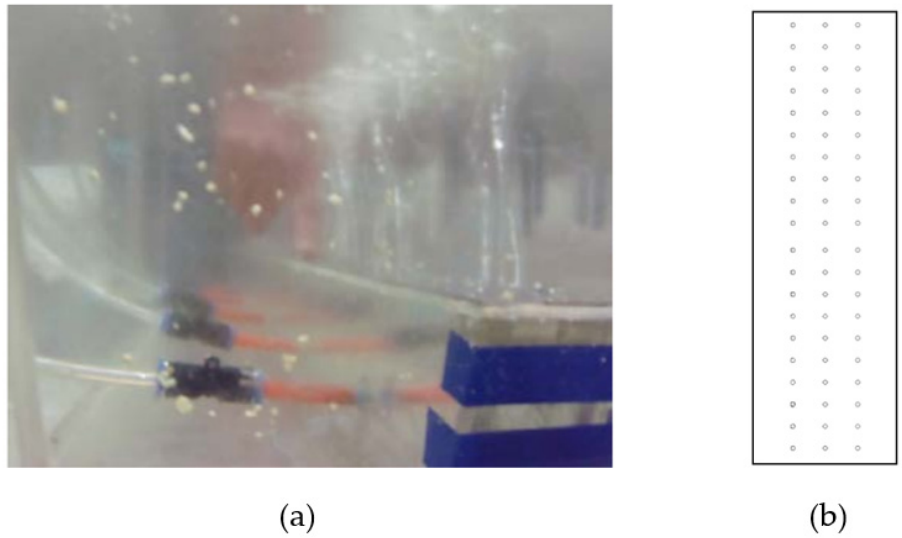
Figure 4. Gas curtain devices used in water model of tundish ( a ) side view of plexiglass box ( b ) top view of the blowing plate.